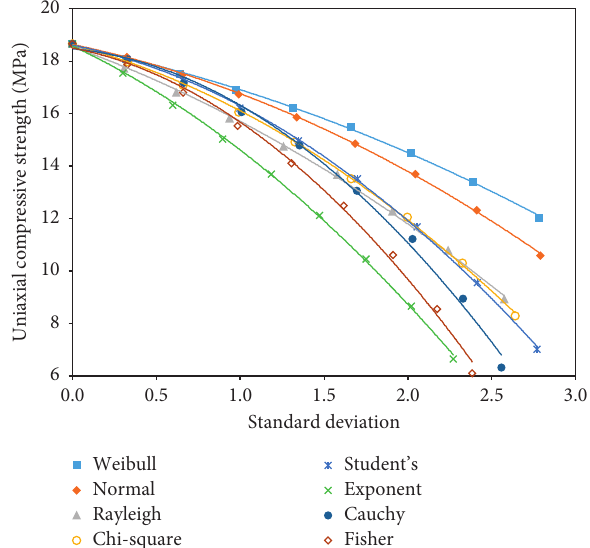
Figure 10: Variation of UCS of coal specimen versus the standard